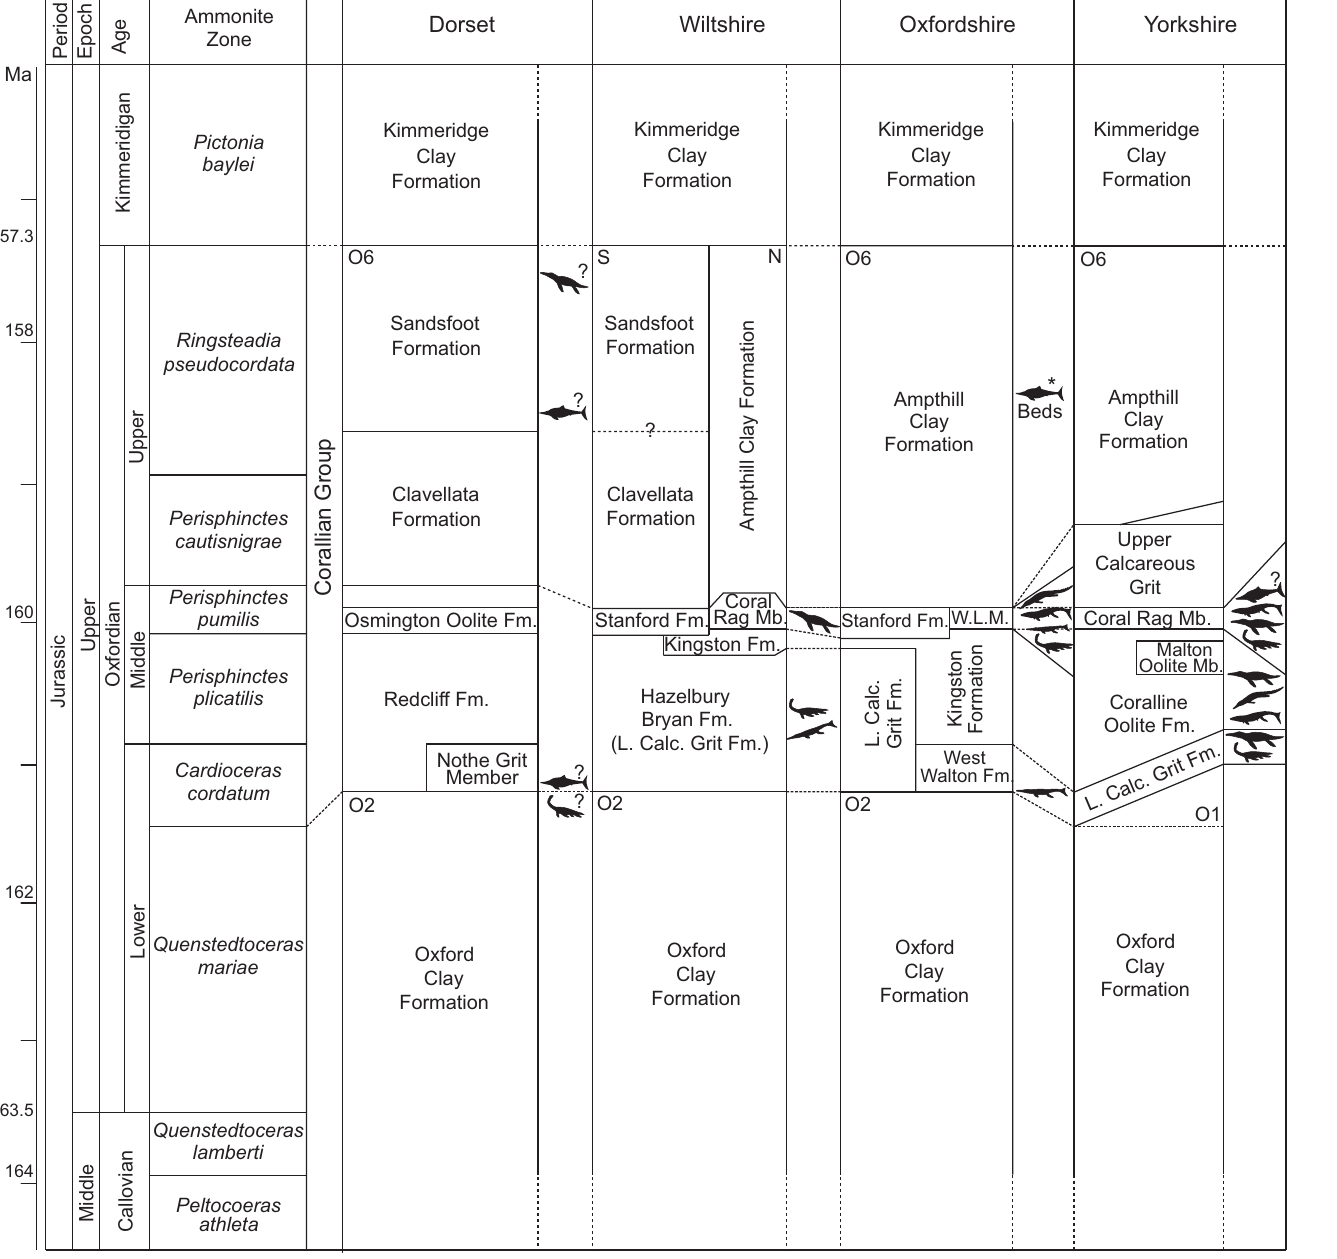
Fig. 2. Stratigraphic columns showing the Oxfordian geological succession the main Corallian fossiliferous counties (from Cope 2000; Wright 2006, 2009; Coe 1995). Abbreviations: Fm., Formation; L. Calc., Lower Calcareous; Mb., Member; W.L.M, Wheatley Limestone Member; ? uncertain occur- rence/lost specimen; * from Bedsfordshire. For explanations of animal silhouettes please see Fig.